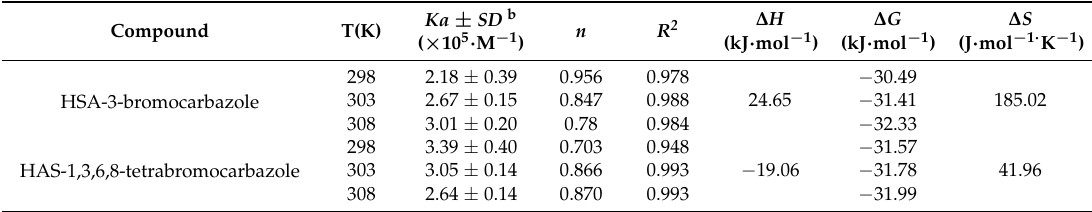
Table 2. Binding constants and thermodynamic parameters of HSA-3-bromocarbazole